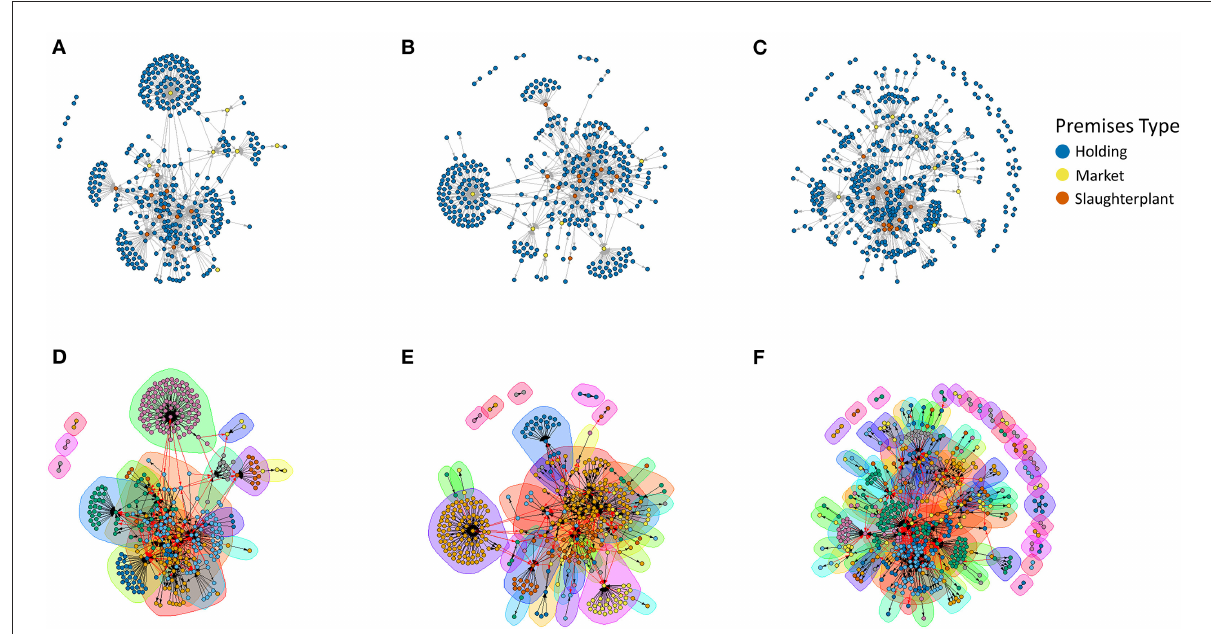
FIGURE2 Non-spatially explicit simplified (repeated edges and loops removed) North Macedonian live pig movement networks for (A) 2017, (B) 2018, and (C) 2019. Communities within the network were identified using the Walktrap community finding algorithm, with (D) 17 communities identified in 2017, (E) 33 communities identified in 2018, and (F) 85 communities identified in